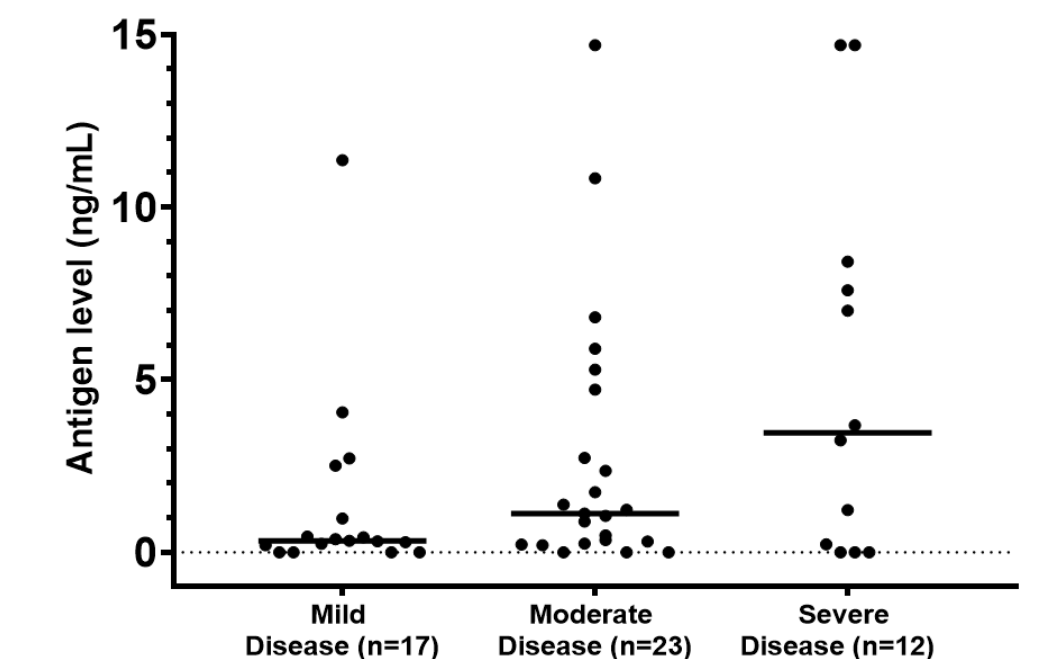
Figure 2. Disease severity and Blastomyces urine antigen level. Horizontal lines represent mean values ( p = 0.06). In terms of antifungal therapy, 38.9% (81/208) of patients received induction treat ‐ ment with a formulation of amphotericin B. Of patients treated with an azole (with or without induction with amphotericin B), 90.7% (166/183) received itraconazole and 9.3% (17/183) voriconazole as the first azole. As shown in Supplementary Table S2, voricona ‐ zole was more commonly used as the first azole in patients with CNS involvement. All other clinical characteristics were similar between the two groups. Three patients (1.4%) had disease relapse/recurrence. Their clinical characteristics are summarized in Table 6. None of the patients had a known immunocompromising condi ‐ tion. Based on clinical review, patient 1 probably had re ‐ exposure to Blastomyces conidia that led to the recurrence with pulmonary consolidation on the contralateral lung. Patient